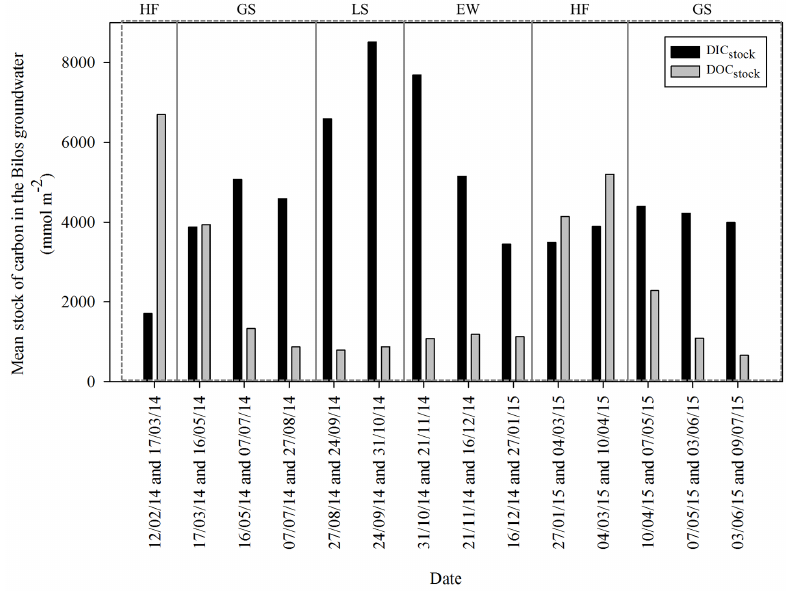
Figure 6. The mean DIC and DOC stocks between two sampling dates in Bilos groundwater. HF, GS, LS and EW represent high-flow